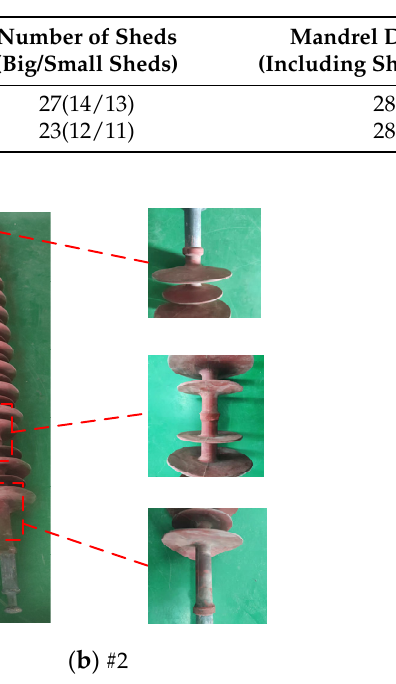
Table 1. Parameters of samples.